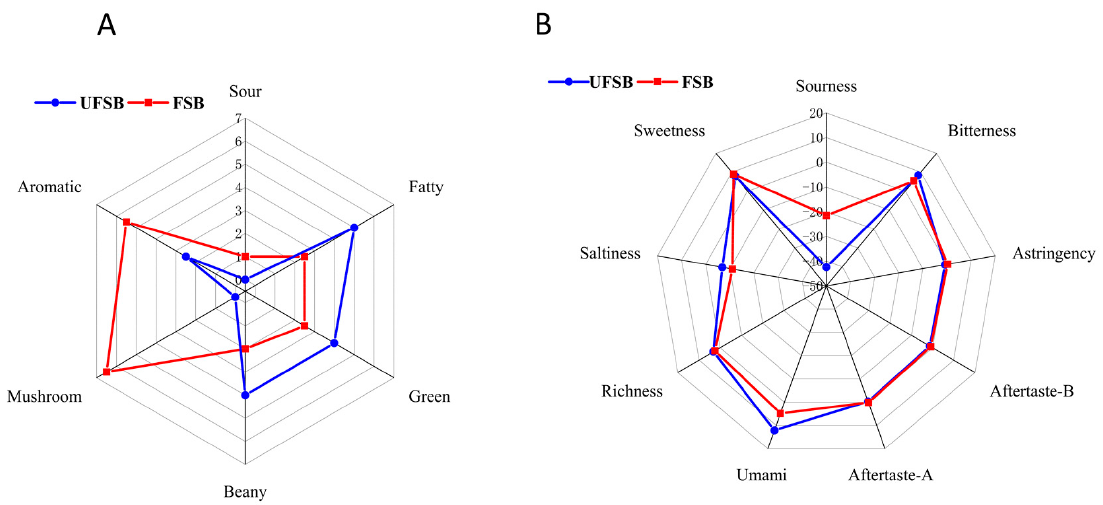
Figure 4. Radar chart of FSB and UFSB. ( A ) Sensory property of soy beverages, ( B ) electronic tongue measurement of soy beverages. measurement of soy